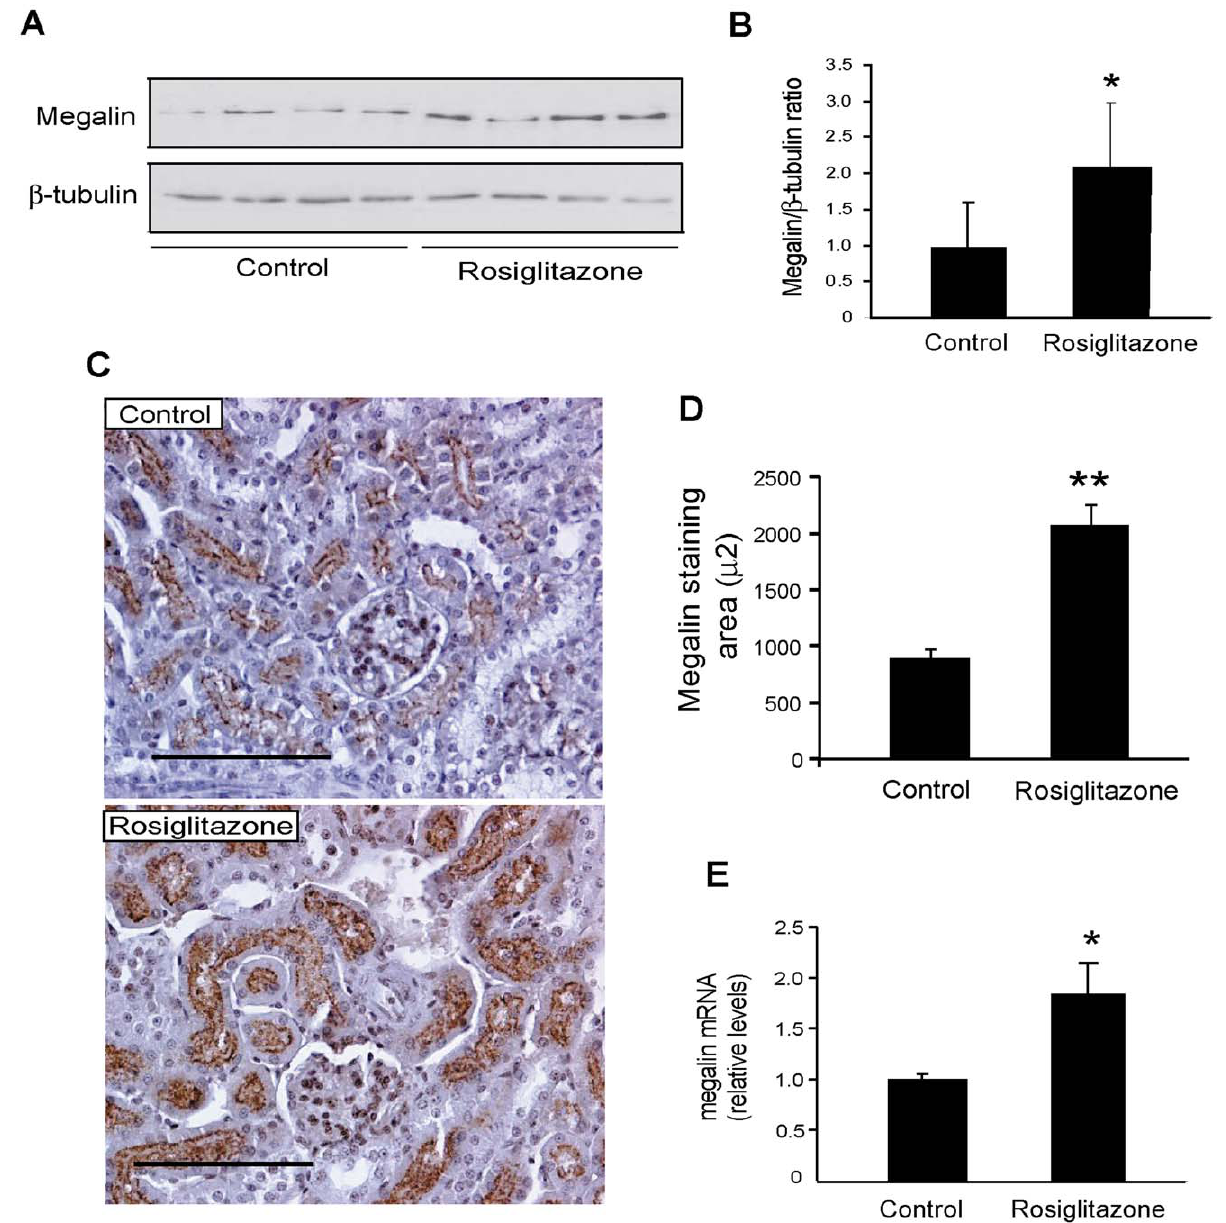
Figure 5. PPAR c agonists regulate megalin expression invivo in mice. BALB/c mice (n=4–6/per group) received rosiglitazone (20 mg/kg/ day) or vehicle for 10 days. ( a ) Kidney extracts were used to determine megalin protein levels. b -tubulin was used as loading control. ( b ) The bands in the blots were quantified by densitometry, and the results were plotted as the ratio of megalin/ b -tubulin for each condition. ( c ) Immunohistochemical staining of megalin in kidney sections (cortex) showing increased immunostaining for megalin in rosiglitazone-treated mice compared to control mice. Renal tissue was immunostained using an antibody that detects the megalin cytoplasmic domain. Bar=100 m m. ( d ) The megalin-immunostained area was significantly increased in the rosiglitazone group compared to the control group as measured by morphometric analysis. The graph shows the quantification of the megalin-stained area in m m 2 . ( e ) Megalin mRNA levels were determined by qPCR. Data are expressed as means 6 SD. *P , 0.05 vs. control, **P , 0.0001 vs.